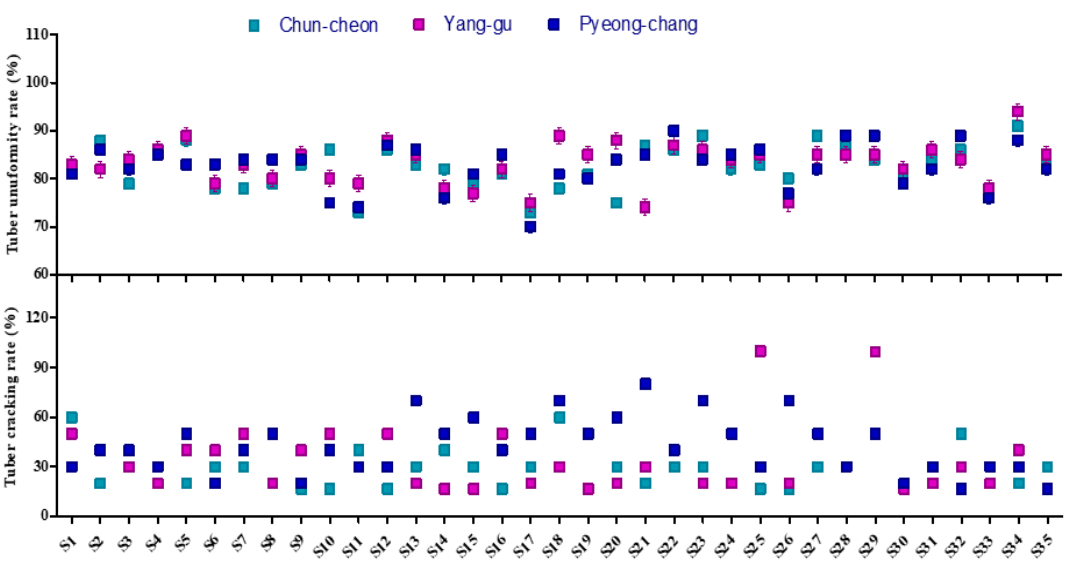
Figure 2. Tuber uniformity rate (%) and tuber cracking rate (%) of 35 potato lines grown in three agro-ecological regions: Chuncheon (low altitude), Yang-gu (middle altitude), and Pyeong-chang (alpine) in South Korea. The bars represent standard error mean (SEM).